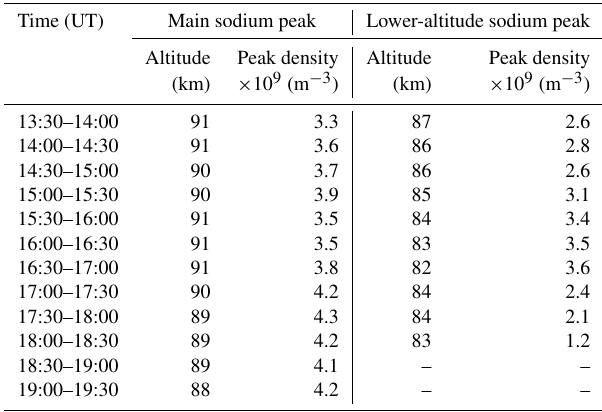
Figure 2. The 30min averages of sodium densities from the vertical beam.